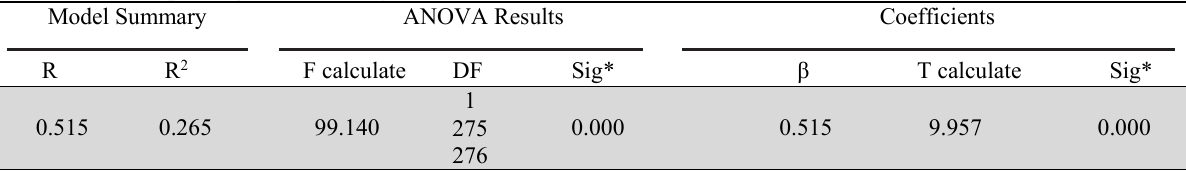
Results of simple regression analysis for the effect of ER-R on IO Model Summary ANOVA